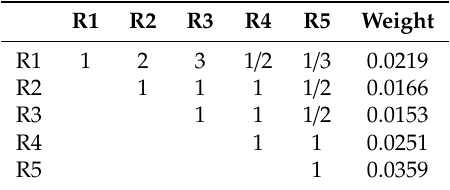
Table A5. Pairwise comparison matrix of Resource